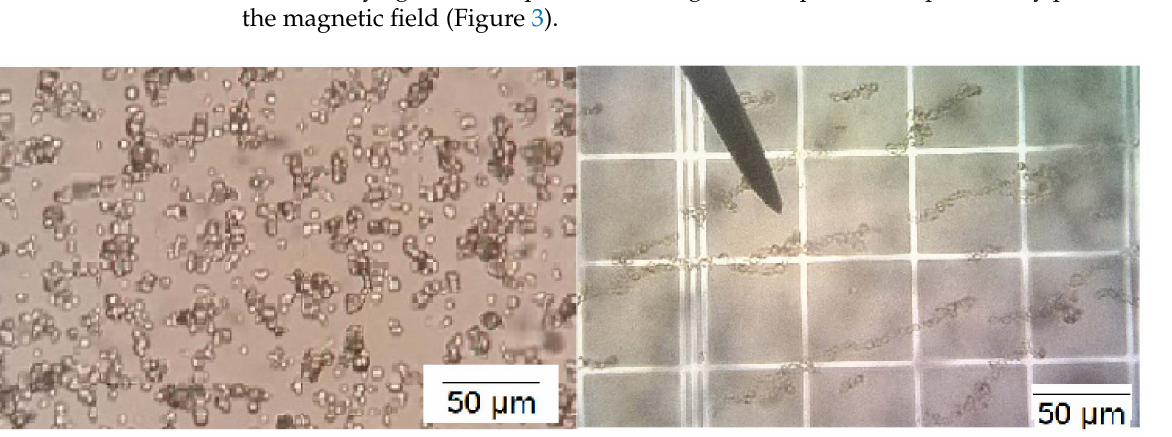
Figure 3. Capsules: ( left ) before passing over the magnet; ( right ) after passing over the magnet.